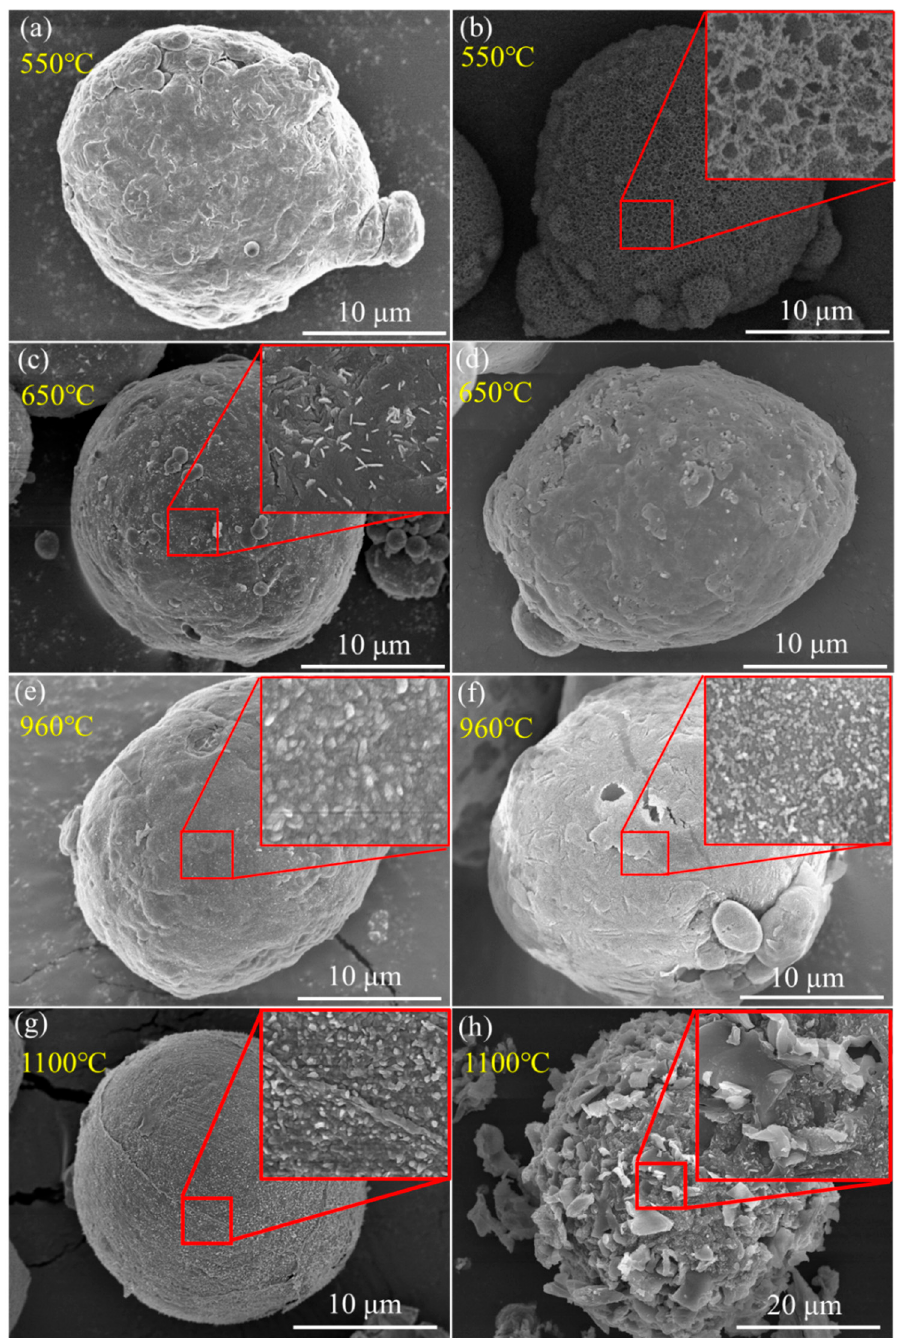
Figure 9. SEM graphs of recovered Al ( a , c , e , g ) and Al / PTFE ( b , d , f , h ) powders at di ff erent temperatures. ( a , b ) 550 ◦ C; ( c , d ) 650 ◦ C; ( e , f ) 960 ◦ C; ( g , h ) 1100 ◦ C. The samples were recovered from TGA